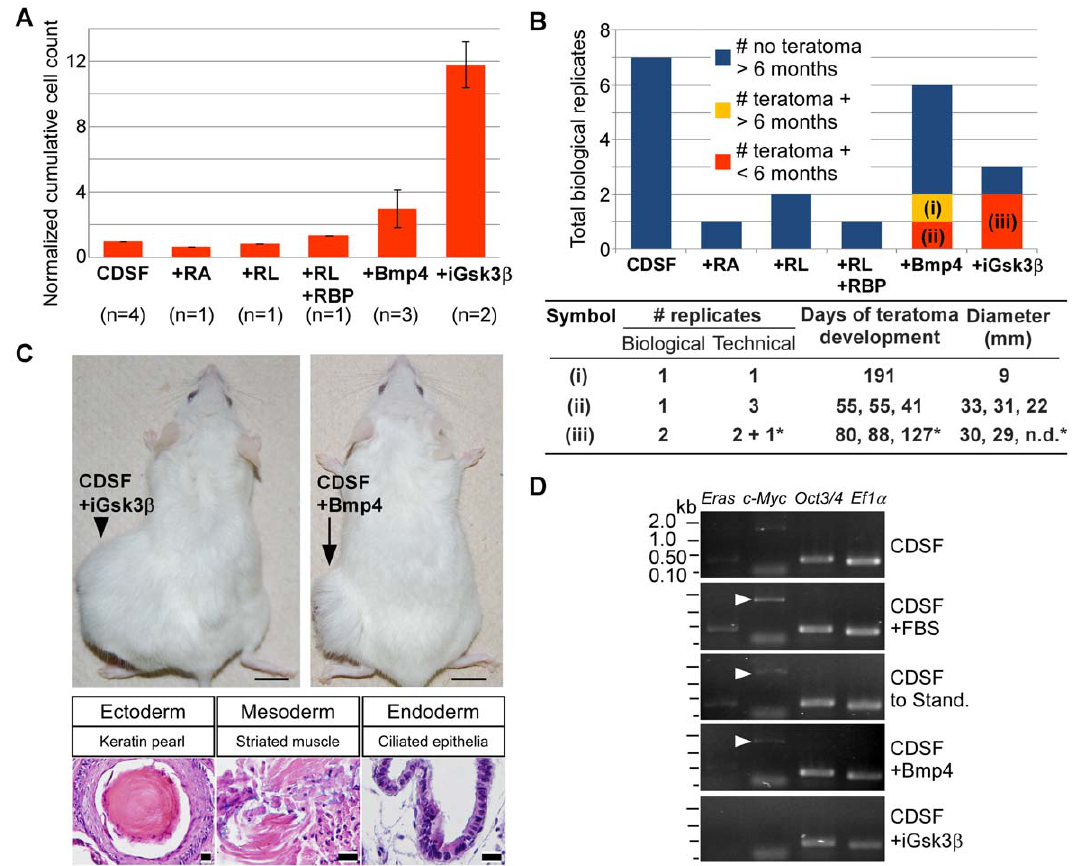
Figure 5. Screening of factors responsible for the tumor-like growth of mouse embryonic stem cells. (A): Cumulative numbers of mESCs were compared among ESCs cultured under each condition indicated for 3 passages. Cell counts were normalized to CDSF conditions. A value for CDSF conditions is normalized to 1. Parentheses indicate the number of biological replicates per condition. Standard errors of the means are indicated by bars. + RA, CDSF with retinoic acid; + RL, CDSF with retinol; + RL + RBP, CDSF with retinol and retinol binding protein; + Bmp4, CDSF with Bmp4; + iGsk3 b , CDSF with the Gsk3 b inhibitor. (B): Total numbers of biological replicates that resulted in formation of teratomas were compared among mESCs cultured under each condition indicated. Orange and yellow boxes indicate the number of biological replicates that developed into teratomas within 6 months and in more than 6 months, respectively. Blue bars indicate the number of biological replicates that failed to form teratomas for more than 6 months. Data for the Gsk3 b inhibitor include results obtained with R1 and W4 mESCs. For those biological replicates indicated as (i), (ii) and (iii) in the bar chart, the number of technical replicates, the number of days needed for the experimental animals to reach their end points, and the sizes of the longest axis of the teratomas are shown per technical replicate. Asterisks (*) indicate that W4 mESCs were transplanted. n.d., not determined. (C, top): NOD-SCID mice that received transplantation of mESCs cultured in CDSF supplemented with Bmp4 (right) or the Gsk3 b inhibitor (left) are shown. Bars, 1 cm. (C, bottom): Representative histological images are shown. The presence of three germ layers (see the legend for Fig. 2) is evident in teratomas developed from mESCs cultured in CDSF supplemented with the Gsk3 b inhibitor. Bars, 20 m m. (D): Abundance of each transcript indicated above was examined in mESCs cultured under each condition on the right by 24 cycles of PCR. Ef1 a was used as a reference. White arrowheads indicate the PCR product of c-Myc .